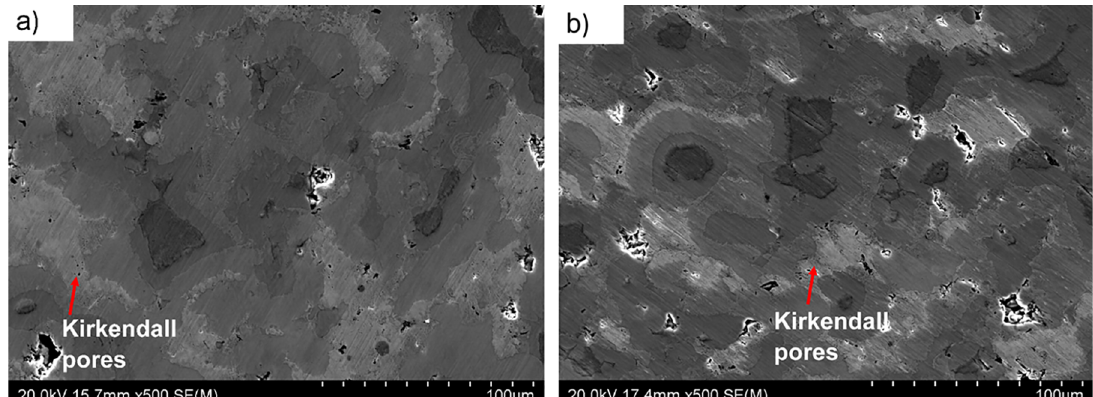
Figure 11. SEM images obtained from samples processed under a) condition 1 and b) condition